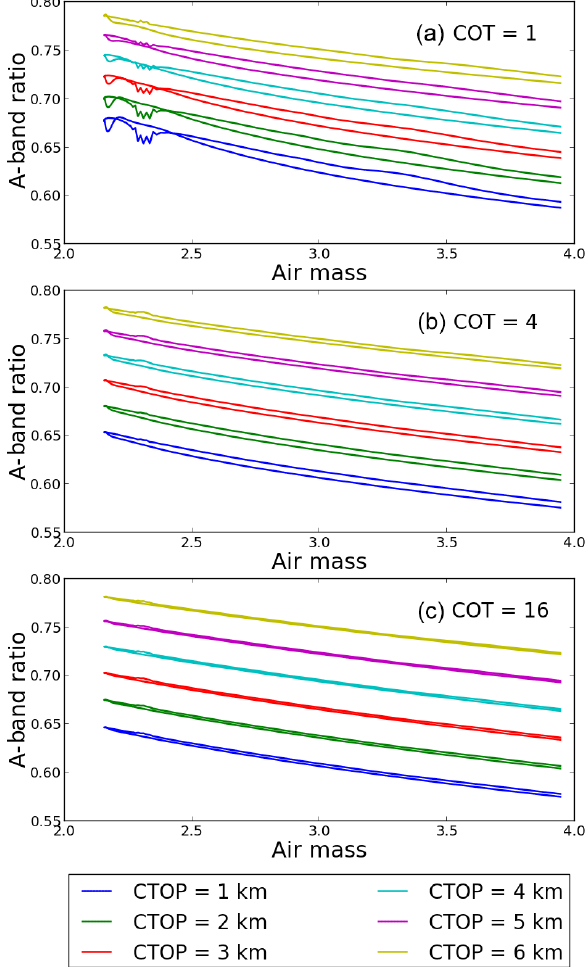
Figure 4. Effect of cloud top altitude variation CTOP on the band ratio. CGT = 0.5km, SZA = 30 ◦ , VAA = 0 ◦ , (a) COT = 1, (b) COT = 4, (c) COT = 16.